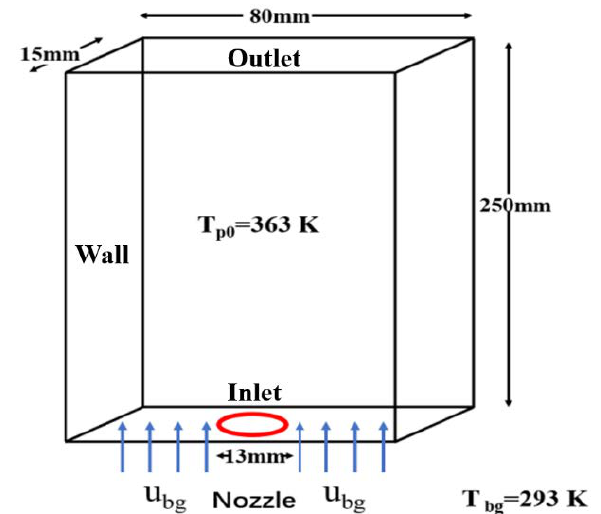
Figure 1. Physical model in gas–solid FBR.